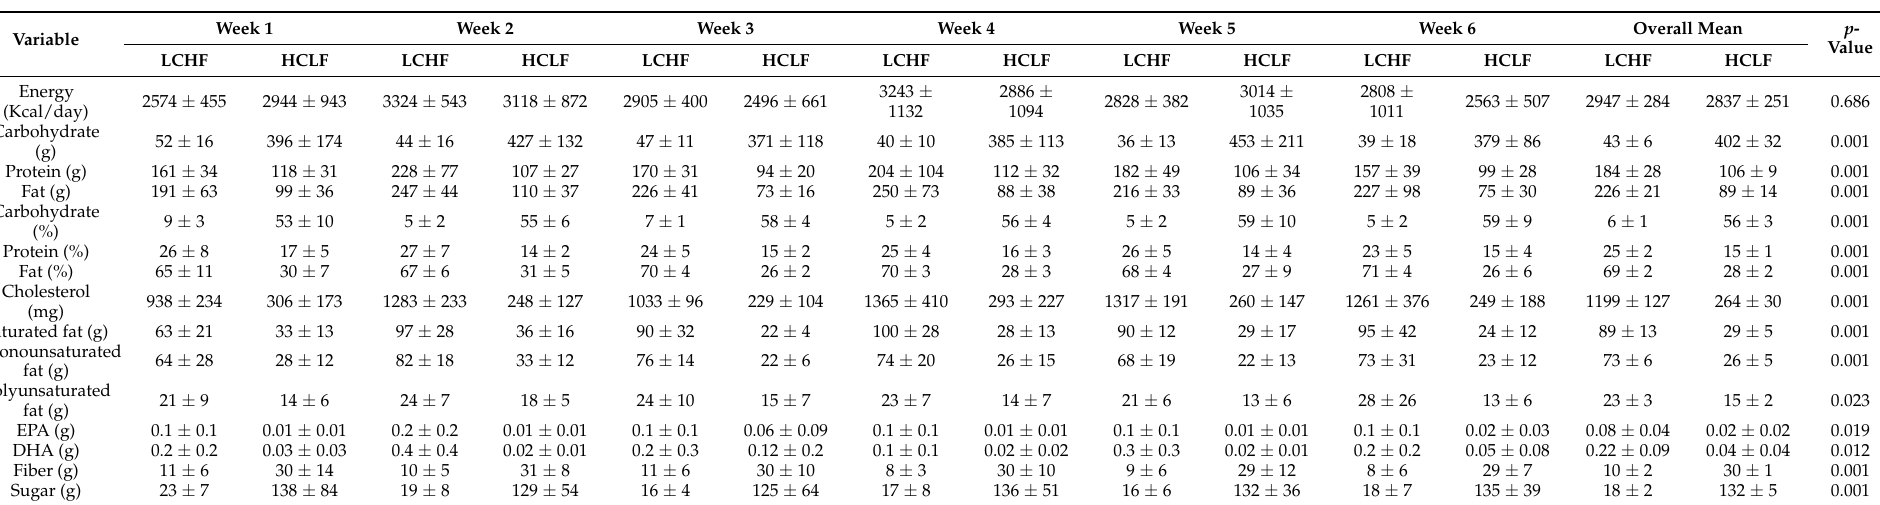
Table 2. Daily Dietary Composition in the Low-Fat and Low-Carbohydrate Diet Groups Over the Course of the